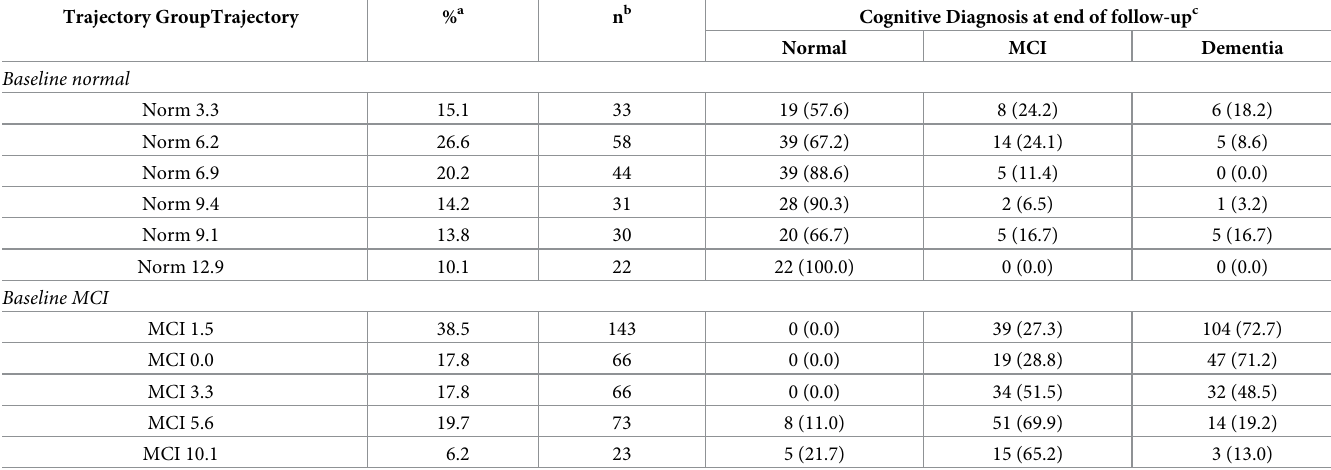
Table 4. Proportion/Number of participants in each trajectory group and cognitive status at end of follow-up. Trajectory GroupTrajectory % a n b